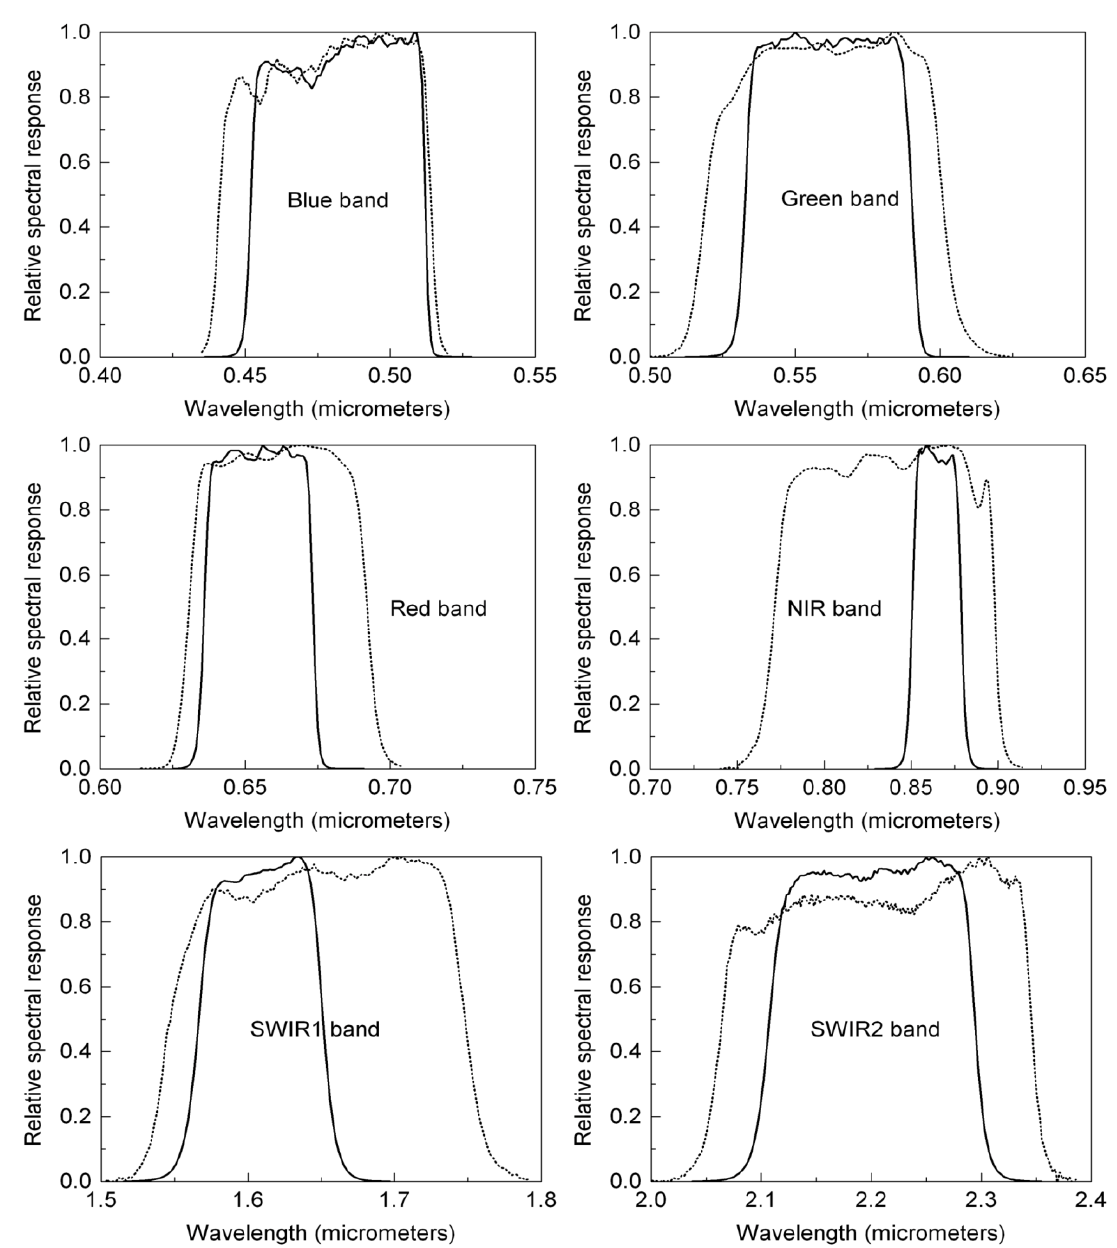
Figure 1. Relative spectral response (RSR) profiles showing the spectral band difference between Landsat-8 Operational Land Imager (OLI) (solid curve) and Landsat-7 Enhanced Thematic Mapper Plus (ETM+) (short dot curve). Note that these response metadata are available from the web page of the Spectral Characteristics Viewer (http://landsat.usgs.gov/tools_spectralViewer.php) provided by the US Geological Survey (USGS). SWIR, short-wave